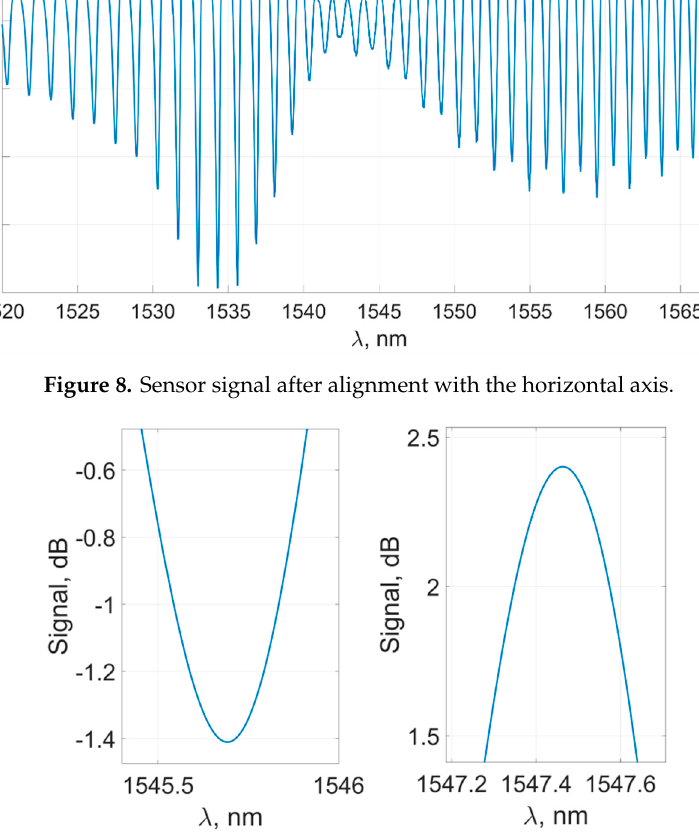
Figure 9. Signal peaks after filtering.